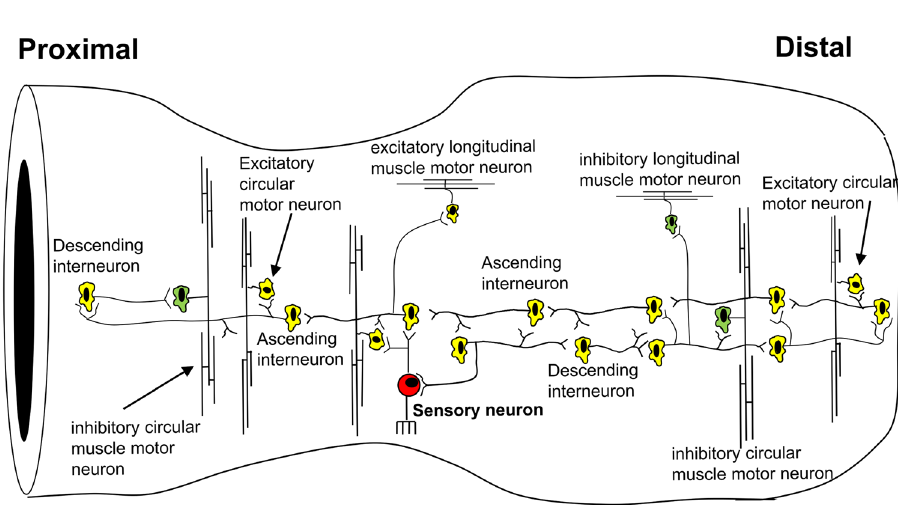
Fig. 10 Intrinsic neural circuit identi fi ed that underlies propagating and non-propagating neurogenic contractions along the colon. The central core of this enteric neural circuit is that ascending and descending interneurons synapse extensively with each other, such that when ascending or descending interneurons are activated this correspondingly activates descending or ascending interneurons, respectively. The major discovery is that long way downstream of any propagating contraction, there is repetitive activation of inhibitory and excitatory motor neurons at the same time. Aborally migrating contraction is temporally delayed downstream because activation of descending inhibitory motor neurons suppress EJPs from reaching action potential threshold by concurrently activated excitatory motor neurons. A major advance is that during the oral contraction in the proximal region, there is concurrent activation of excitatory and inhibitory motor neurons. The same circuit is found to occur in non-propagating contractions, see Supplementary Figs. 4&5 and Supplementary Movie